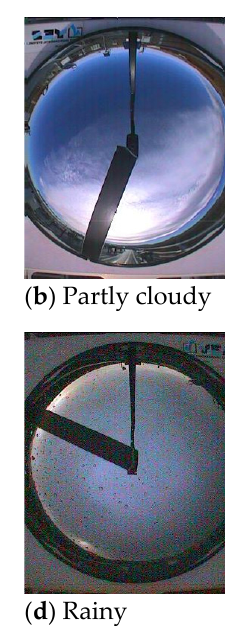
Table 1. The details of meteorological variables in the open database.